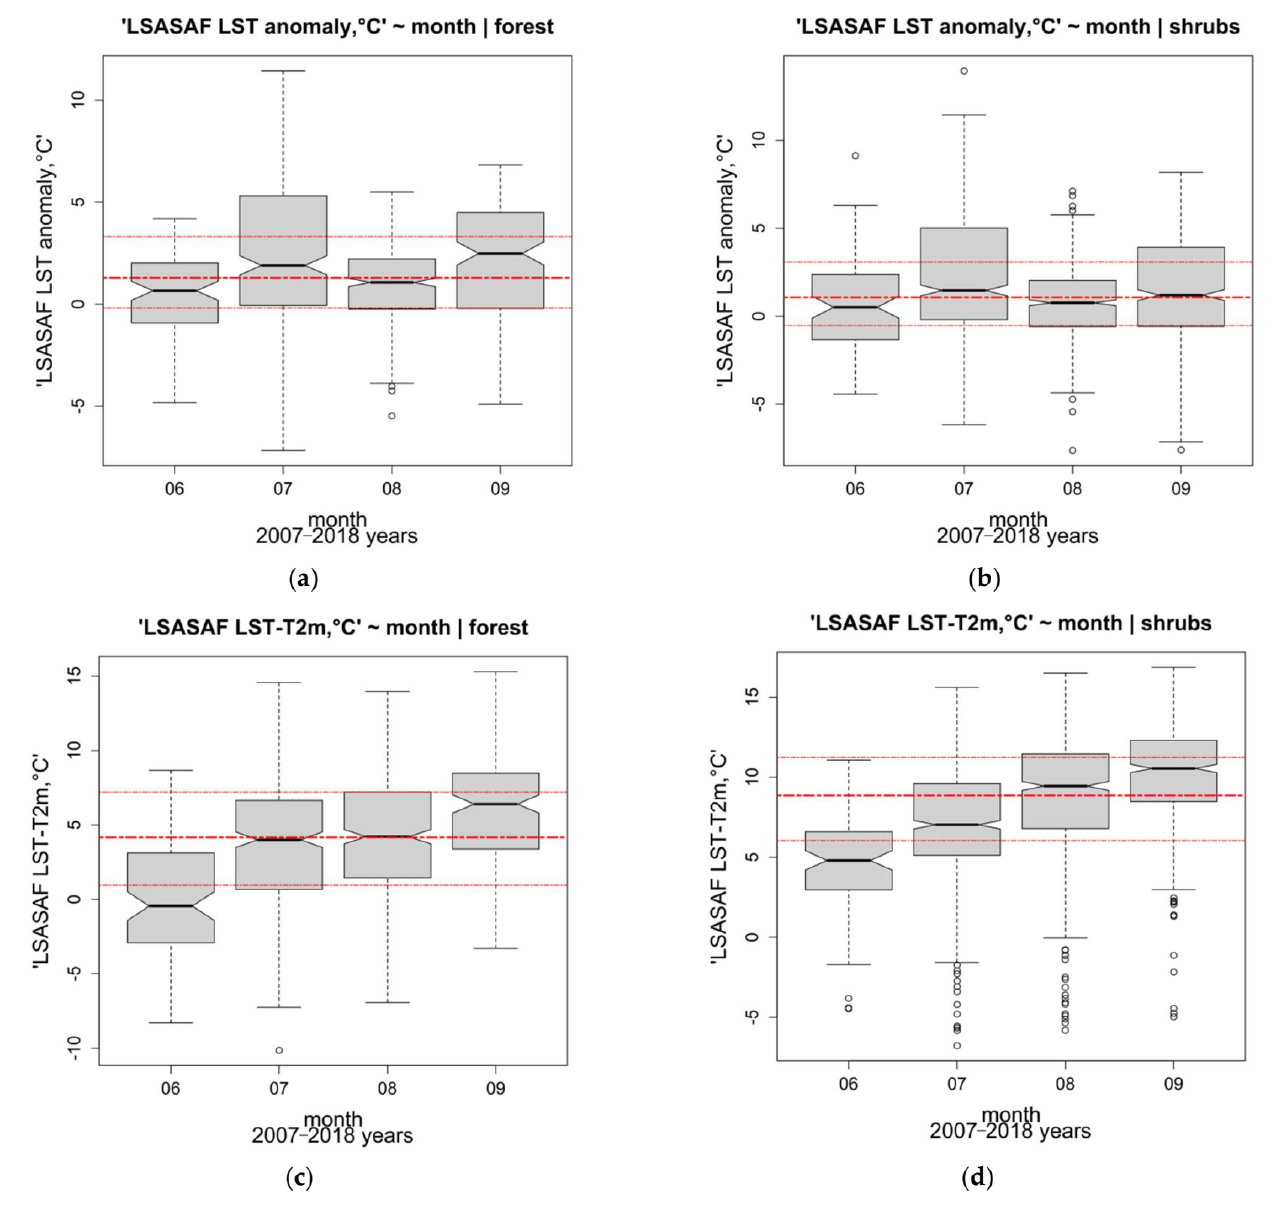
Figure 7. Boxplots of monthly mean values (2007–2018) for the region of Bulgaria during the summer season (June–September) from the LSASAF LST anomaly for ( a ) forest and ( b ) shrubs, and the (LST-T2m) difference for ( c ) forest and ( d ) shrubs. The boxes represent the interquartile range (from 25th to 75th percentile, first and third red line), whiskers cover 99.3% of the data, and the middle (red) lines represent the mean